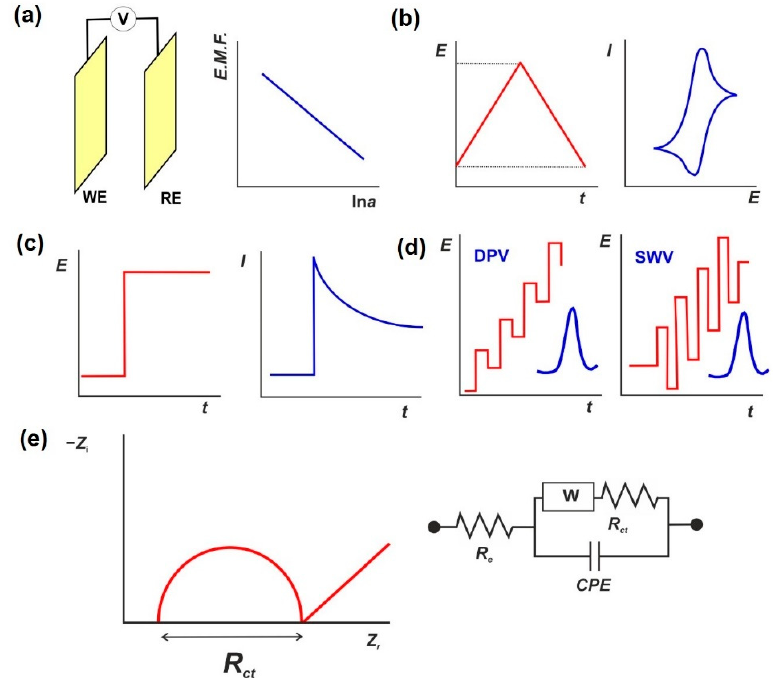
Figure 4. Electrochemical sensors used as transducers of aptasensors: ( a ) potentiometric cell: WE— working electrode, RE—reference electrode, V—voltmeter; ( b ) cyclic voltammetry; ( c ) amperometry; ( d ) differential pulse (DPV) and square wave (SWV) voltammetry. Red line illustrates the shape of current peak obtained; ( e ) electrochemical impedance spectroscopy; the Nyquist diagram and equivalent circuit correspond to the double-electric layer. R e is electrolyte resistance, R ct is charge transfer resistance, W is Warburg impedance, and CPE are constant phase element.